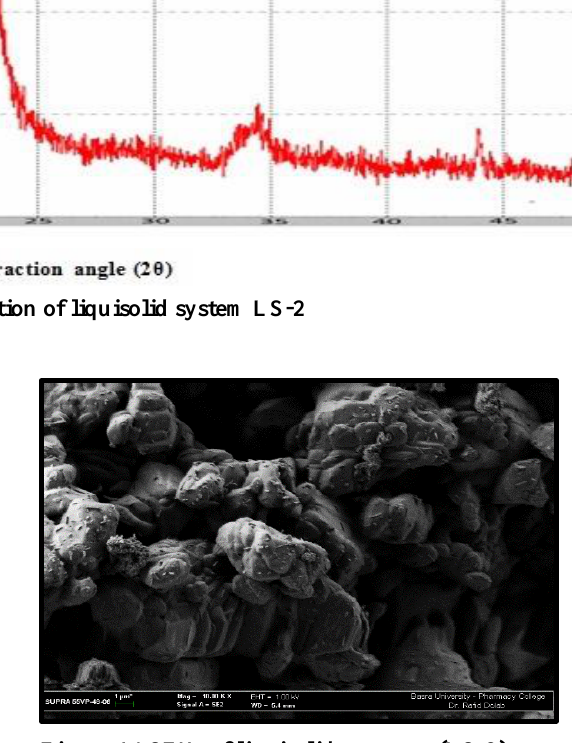
Figure 14.SEM of liquisolid compact